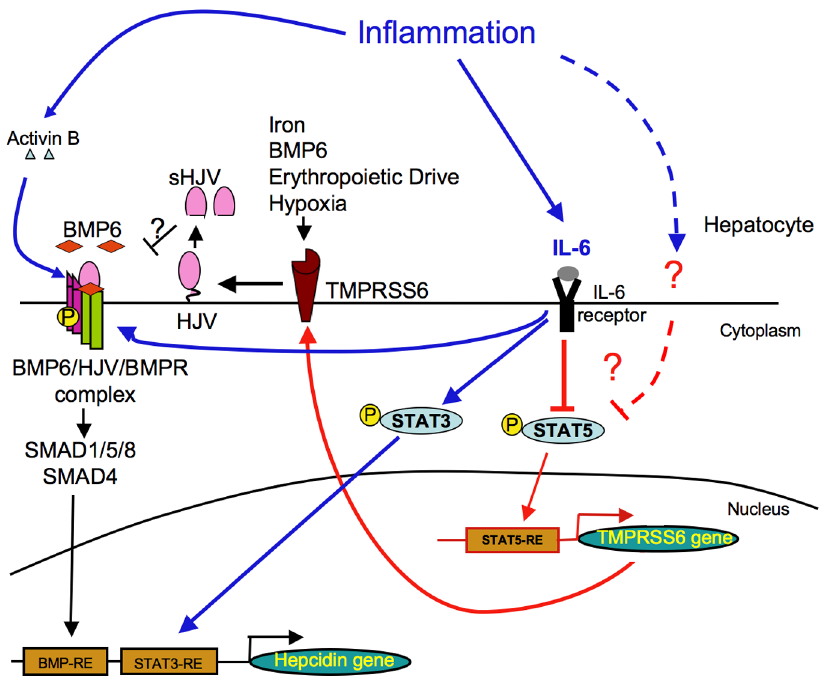
Figure 5. Schematic representation showing proposed role of TMPRSS6 regulation by inflammation via STAT5. We propose that in addition to being stimulated by several signals that regulate hepcidin such as iron, BMP6, erythropoeitic drive, and hypoxia, TMPRSS6 expression is also inhibited indirectly by IL-6. IL-6 stimulates hepcidin expression through the induction of STAT3 phosphorylation and through the stimulation of the BMP6-HJV-SMAD pathway activity, leading to binding of p-STAT3 on STAT3-responsive element (STAT3-RE) and SMAD complexes to BMP- responsive elements (BMP-REs) on the hepcidin promoter. In parallel, inflammation through IL-6 and/or through another non-identified cytokine, inhibits the STAT5 phosphorylation leading to a decrease of P-STAT5 binding on the STAT5-responsive element (STAT5-RE) of the TMPRSS6 promoter resulting in a decrease of TMPRSS6 expression. TMPRSS6 is a negative feedback inhibitor of BMP-SMAD pathway activity and hepcidin expression by cleaving the BMP co-receptor HJV. By inhibiting this negative feedback, TMPRSS6 participates to the hepcidin increase in response to